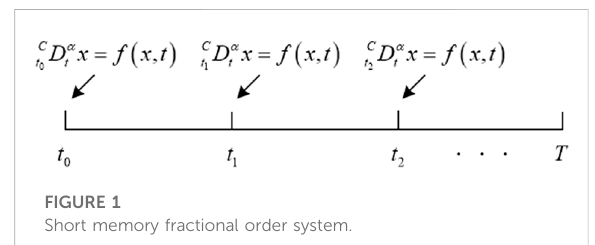
FIGURE 1 Short memory fractional order